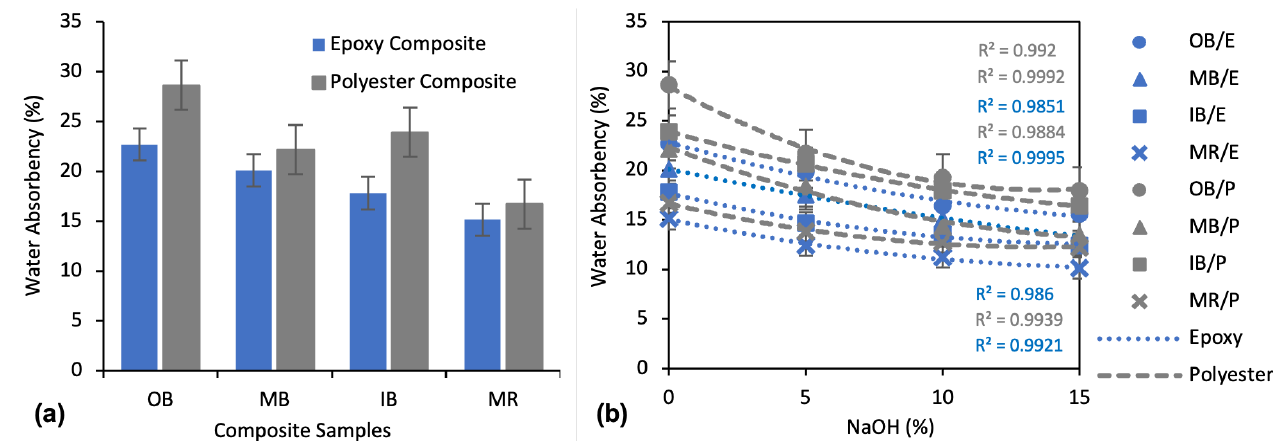
Figure 5. Water absorbency percentage of composites after 24 h water immersion: ( a ) Water absorbency of untreated (0% NaOH) composite samples; ( b ) Effect of alkali treatment on the water absorbency of the composite samples.